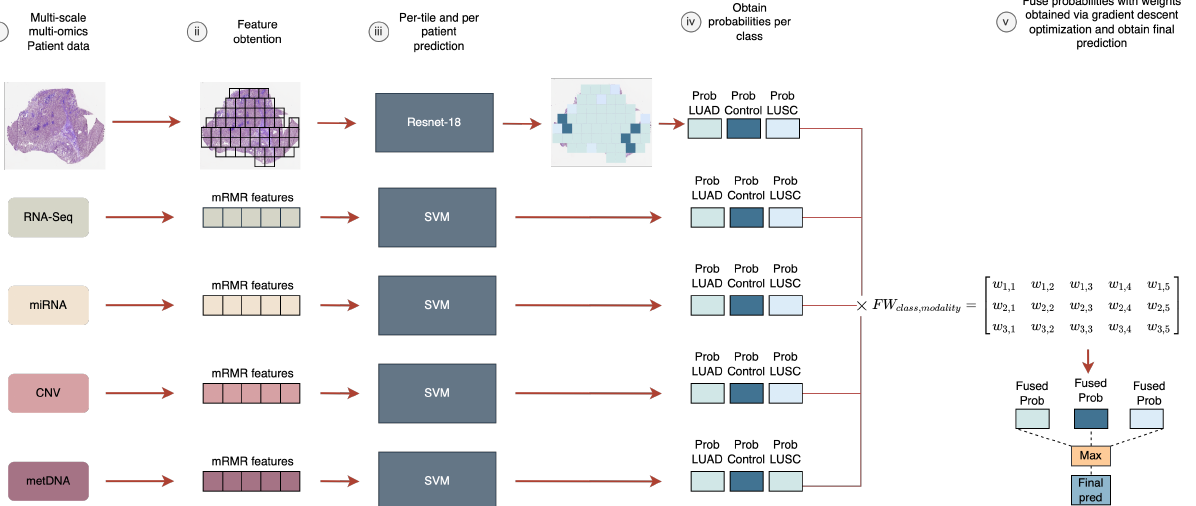
Figure 1. Prediction pipeline for a given sample with multiple modalities. If missing information is present, the probabilities for that modality are zero. ( i ) Multi-scale and multi-omic data available for each sample are obtained. ( ii ) For the imaging modality, non-overlapping tissue tiles of 512 × 512 are obtained. For the molecular modalities, the features are obtained with the aforementioned preprocessing methodology (see Section 3). ( iii ) Probabilities are computed for each modality and class. In the molecular modalities the probabilities are returned by the machine learning model. For the imaging modality, the probabilities are obtained based on the number of tiles predicted per class divided by the total number of tiles. ( iv ) The late fusion model is applied using the previously obtained weights via the gradient optimization, and the final prediction is obtained. ( v ) Fuse probabilities with weights obtained via gradient descent optimization and obtain final